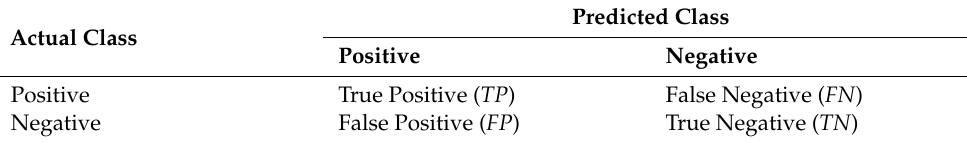
Table 1. Confusion matrix.